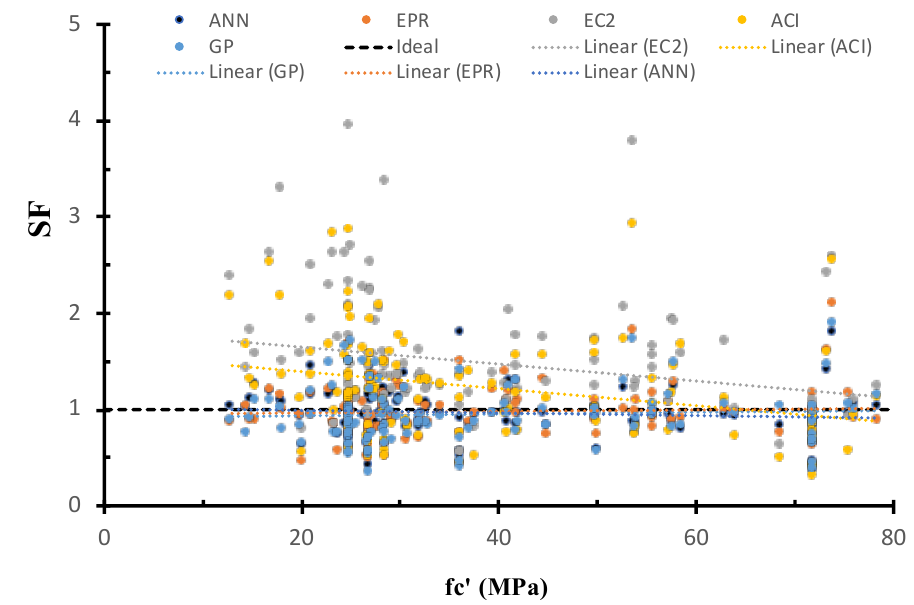
Figure 9. SF calculated using various models versus 𝑓 𝑐′ .